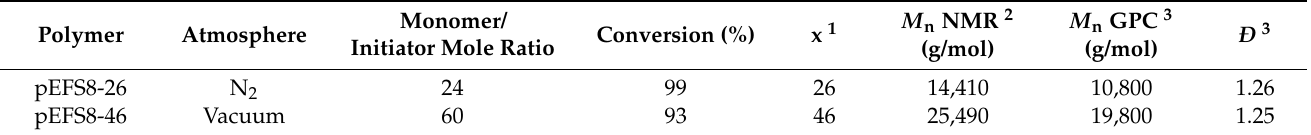
Table 1. Physico-chemical properties of the synthesized pEFS8-x polymers.